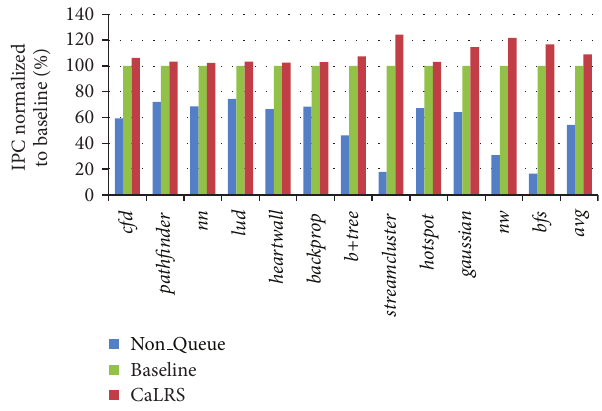
Figure 7: CaLRS performance